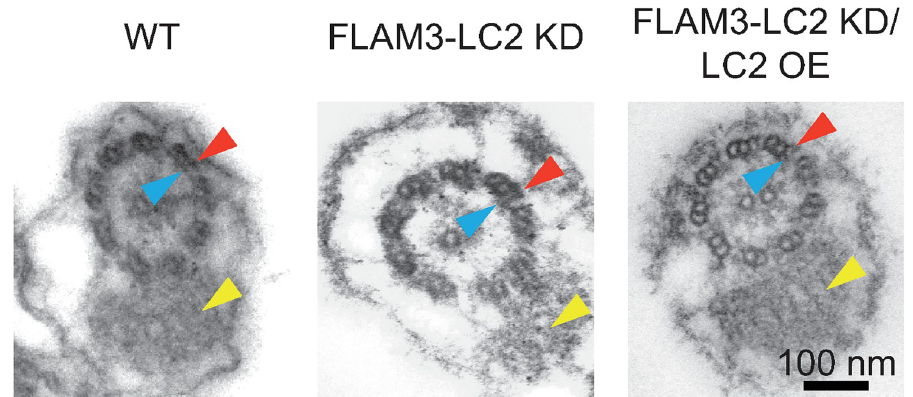
Fig 3. Stable assembly of outer arm dynein into the axoneme does not require TbLC2. Transmission electron microscopy (TEM) images of wild-type (WT, left ), FLAM3-LC2 KD ( middle ), and FLAM3-LC2 KD/LC2 OE ( right ) cells show the axoneme (canonical 9+2 microtubule arrangement) and paraflagellar rod ( yellow arrowheads ). The outer arm ( red arrowheads ) and inner arm ( blue arrowheads ) dyneins were intact in all three cell lines. The scale bar is 100 nm, and all micrographs have the same magnification.